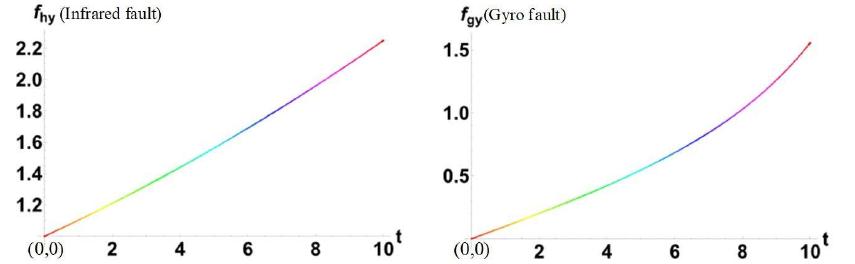
Figure 1. Development of single faults f gy and f hy on a fault information manifold over time. The FID of f gy ( k ) is 1.55741, and the FID of f hy ( k ) is 1.25, which means that